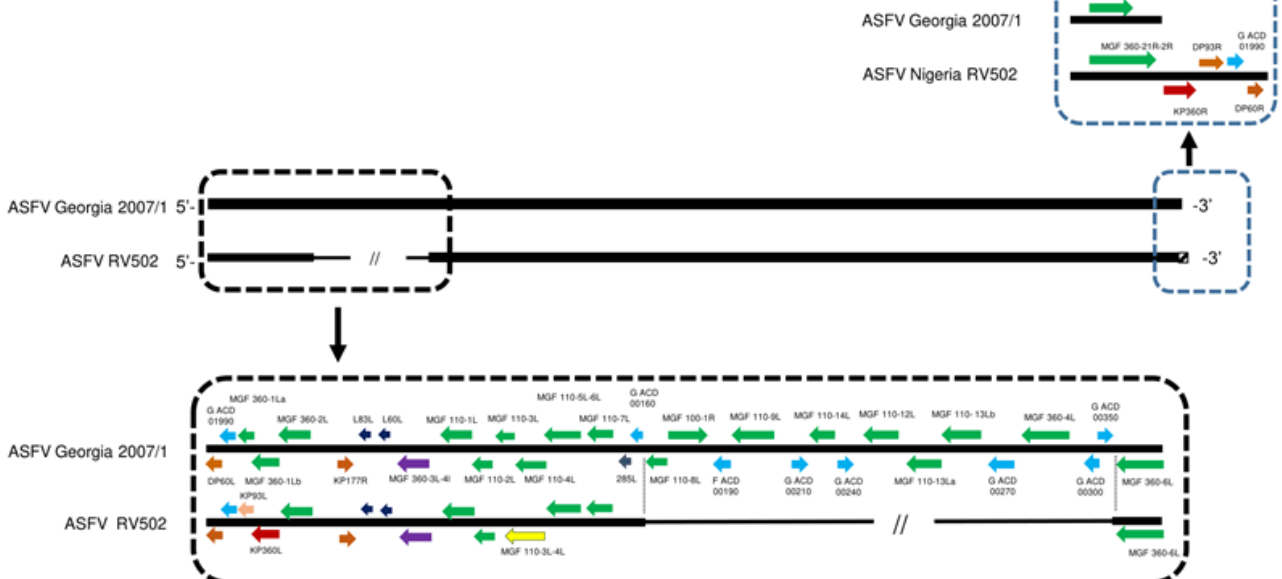
Figure 2. Diagram showing the sites of deletion and reorganization in the ASFV RV502 genome compared to the ASFV Georgia 2007/1. ASFV RV502 genome is lacking 6535 bp between the nucleotide positions 11,760–18,295 of the genome which includes 14 genes. Additionally, a 688 bp deletion resulted in an in-frame fusion of MGF 110-3L and 110-4L (yellow arrow). A single nucleotide insertion within the MGF 360 1L gene, changed MGF360 1L to the KP360L (red arrow). At the 3′ end of the genome, there is an apparent reverse complement duplication of the 5′ end of the genome, creating an in-frame fusion between MGF 360-21R and 2L, and continues to include a duplication of KP360L (labelled as KP360R).